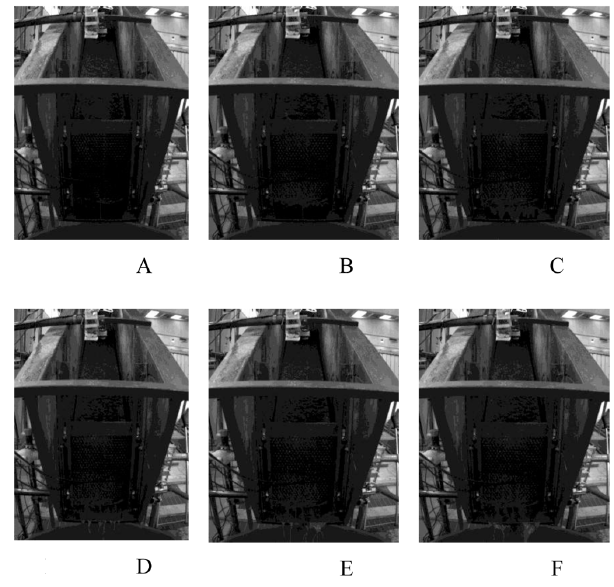
Fig. A4. Impact sequence, taken from Camera 2, for the rigid drain- ing barrier vertically mounted. (A) debris flows at the onset of im- pact, (B) initial phase of the impact, (C) development of a very small vertical jet-like wave, (D–F) the small jet-like wave returns inside the channel without any considerable increment of the pres- sure